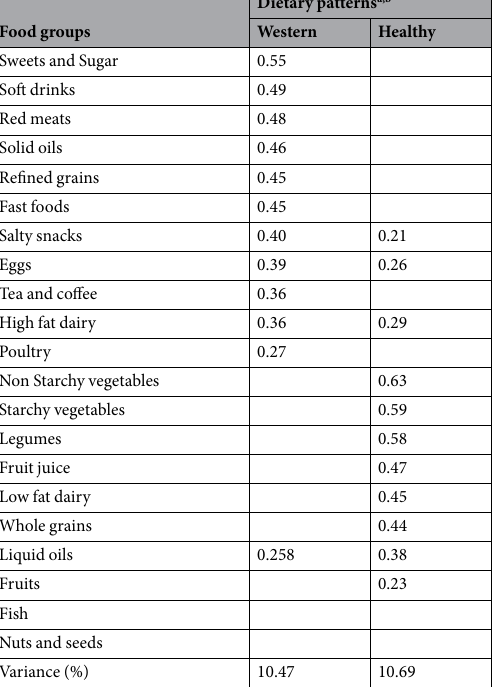
Table 2. Factor loadings for the two dietary patterns identified in study participants. a Values are factor loadings of dietary patterns measured by factor analysis. Factor loadings below ± 0.2 are not shown in the table for simplicity. b Eigenvalues > 1, Kaiser-Meyer-Olkin (KMO):